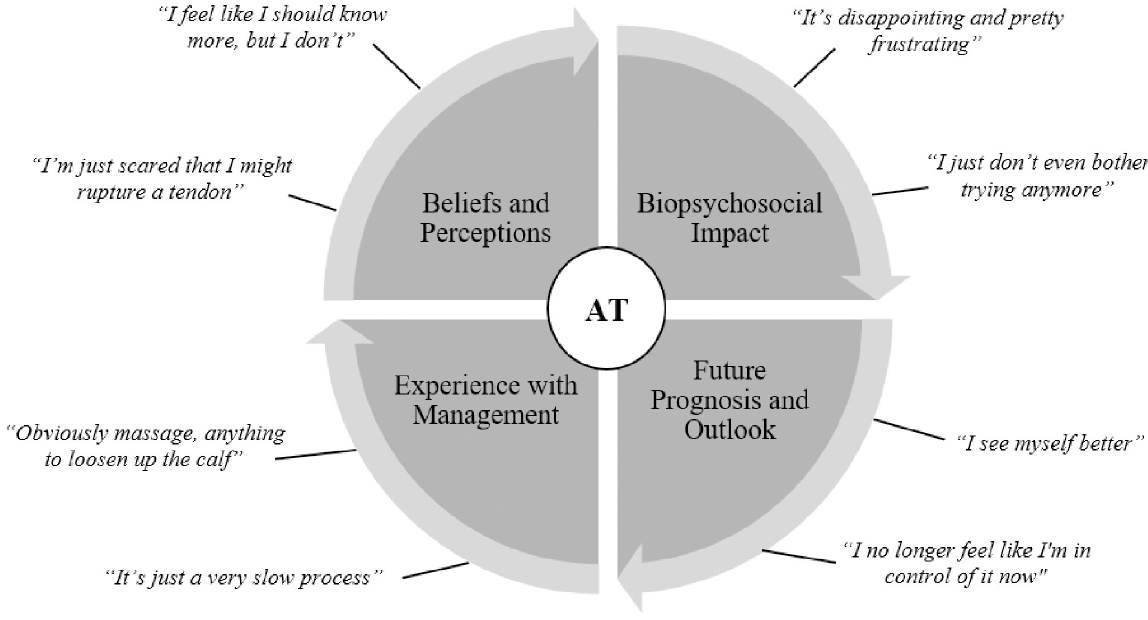
Fig 1. Main themes and representative participant quotes. Achilles tendinopathy